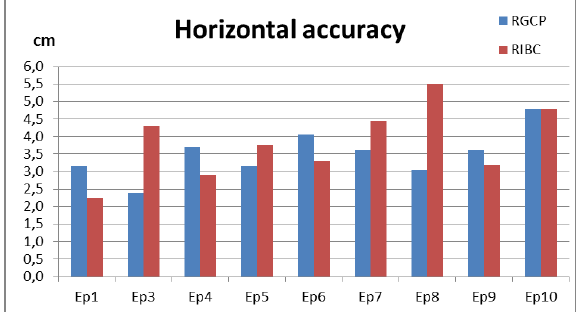
Figure 7. Comparison of horizontal RMSE between RIBC and RGCP